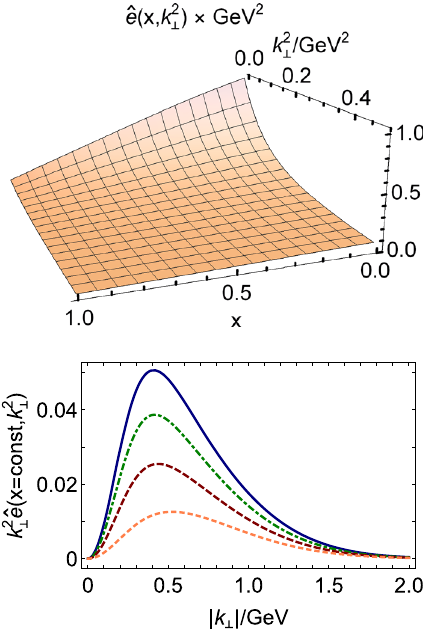
Fig. 8 Upper panel – Twist-two pion TMD, Eq. (69). This function is symmetric around the line x = 1 / 2. Lower panel – k 2 ⊥ f 1 ( x , k 2 ⊥ ) at: x = 0 – solid blue curve; x = 1 / 4 – dot-dashed green curve; and x = 1 / 2 – dashed dark-red curve. Scale is ζ H , Eq. (61)